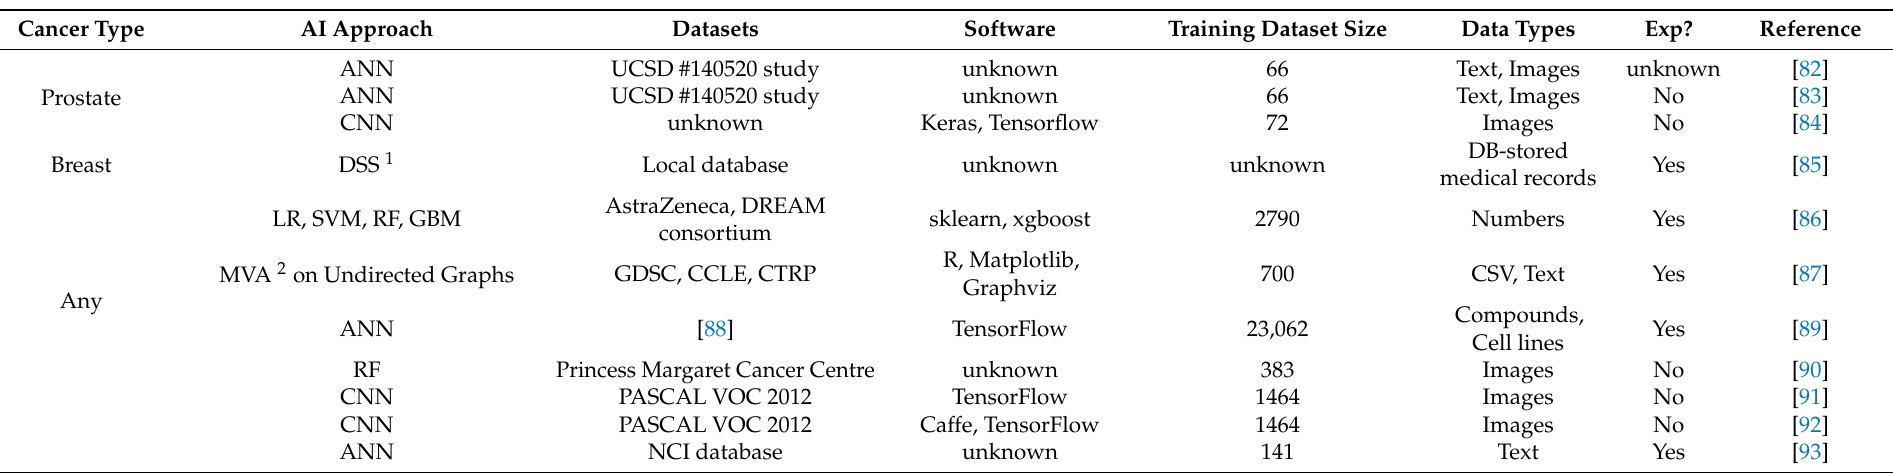
Table 4. Manuscripts applying ML to estimate drug doses or finding drug combinations for cancer therapies.